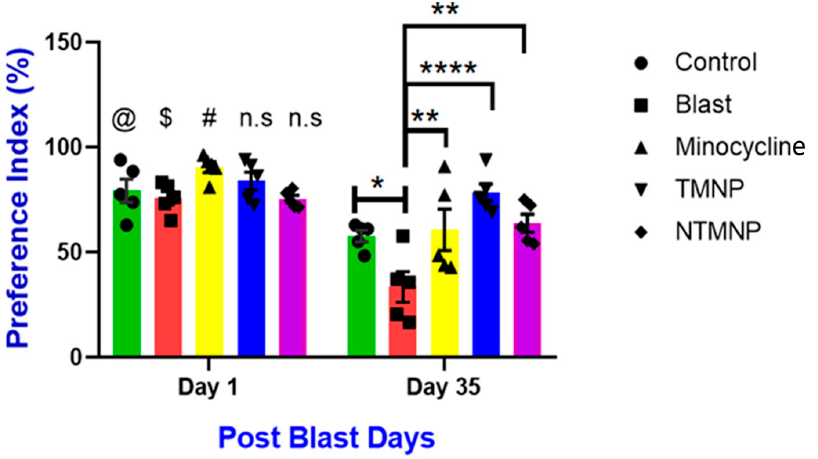
Figure 9. Free minocycline, targeted (TMNP), and non-targeted minocycline (NTMNP) nanoparticles mitigated moderate blast-induced short-term memory impairment. @, $ and # represent significant differences between day 1 and day 35 within the groups. Two-way ANOVA-mixed effect model design with Bonferroni correction used to analyze the difference between the days). * p < 0.05, ** p < 0.01, **** p < 0.001, and n.s is no significance.